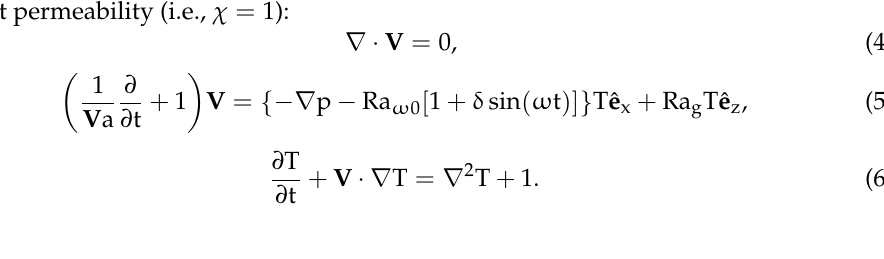
T − . For this scaling, κ * is